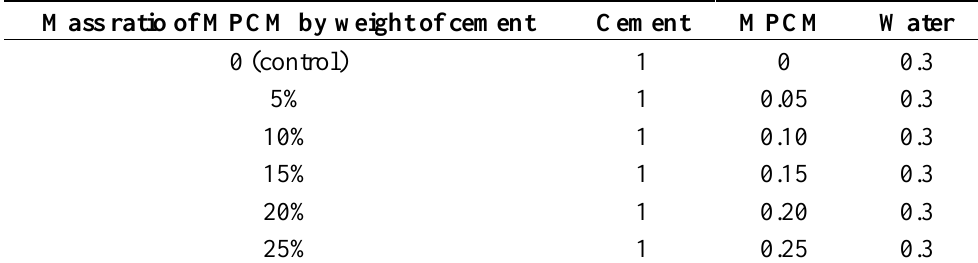
Table 1. Mix proportion of harden cement paste with MPCM.